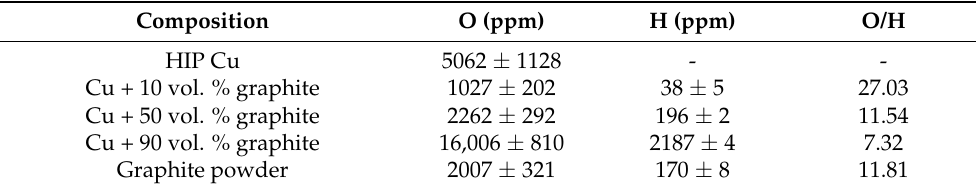
Table 2. The results of OHN analyses for the tested Cu–graphite composites, pure HIPed copper, and original graphite